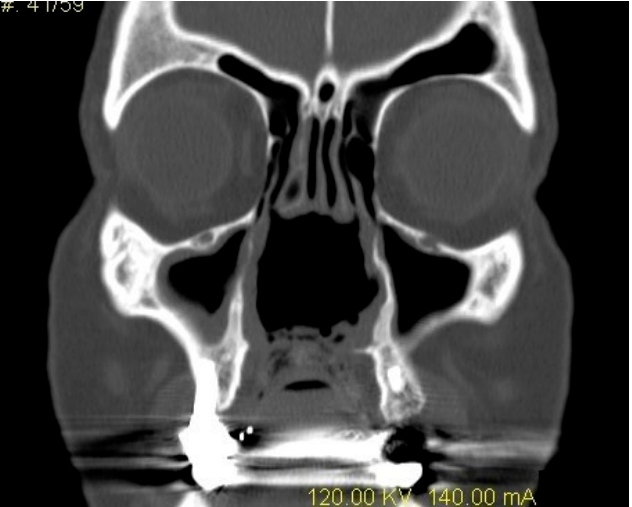
Figure 2. Patient 2: A coronal CT scan showing a wide erosion of midline structures (septum and turbinates), including a palatal perforation treated with a correctly shaped palatal obturator